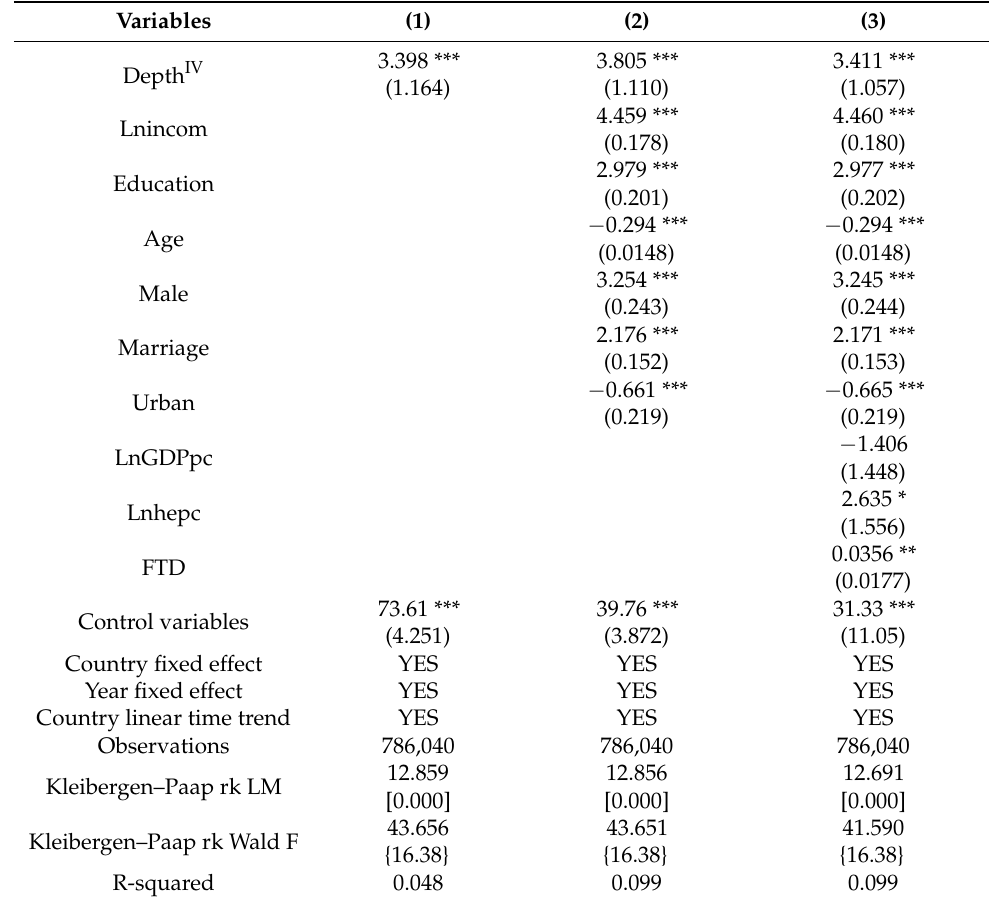
Table 6. Endogeneity test